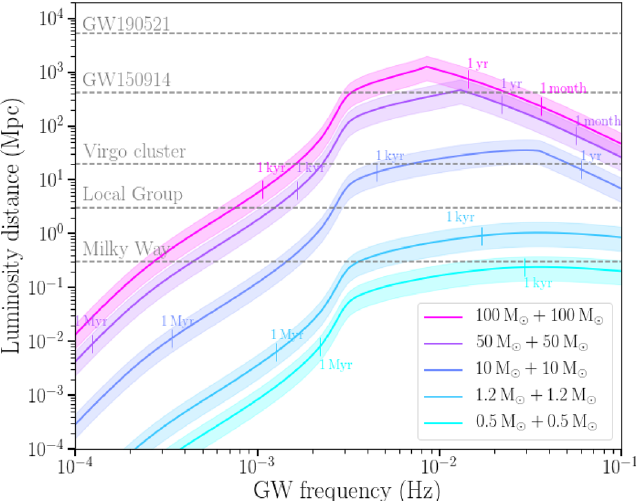
Fig. 1 Distance to which LISA binaries can be detected as a function of GW frequency. The coloured lines represent the SNR threshold of 7 (here computed assuming a mission duration of 4 year with 100% duty cycle) for (quasi-)stationary equal-mass circular binaries of different total masses in the distance – GW frequency parameter space. The shaded range represents angle-averaged curve limits for the optimal and worst binary orientation. The ticks on the curves represent binary merger times: for merger times (cid:6) 4 year the binary will be seen by LISA as a monochromatic GW source, whereas for merger times \ 4 year the binary will be seen as evolving. Note in particular that evolving sources like GW190521 and GW150914 remain within the LISA band for less than the mission lifetime. Image credit: Antoine Klein & Valeriya Korol